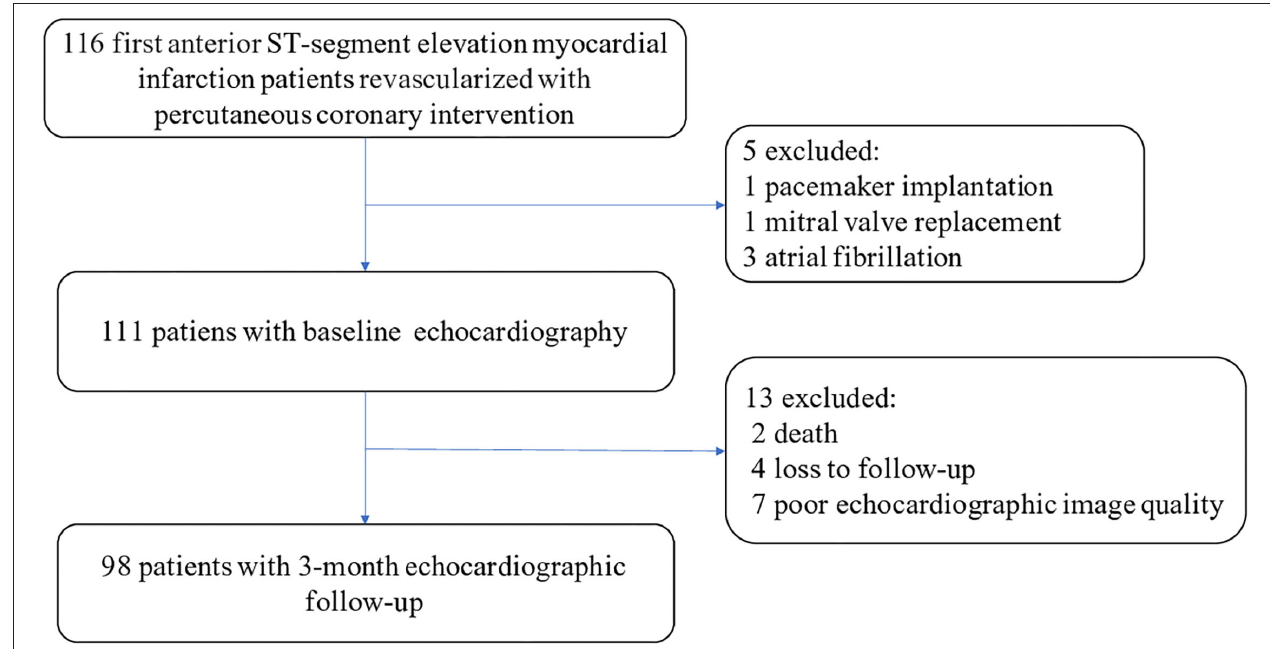
FIGURE 2 | Flowchart for the selection of our study population.